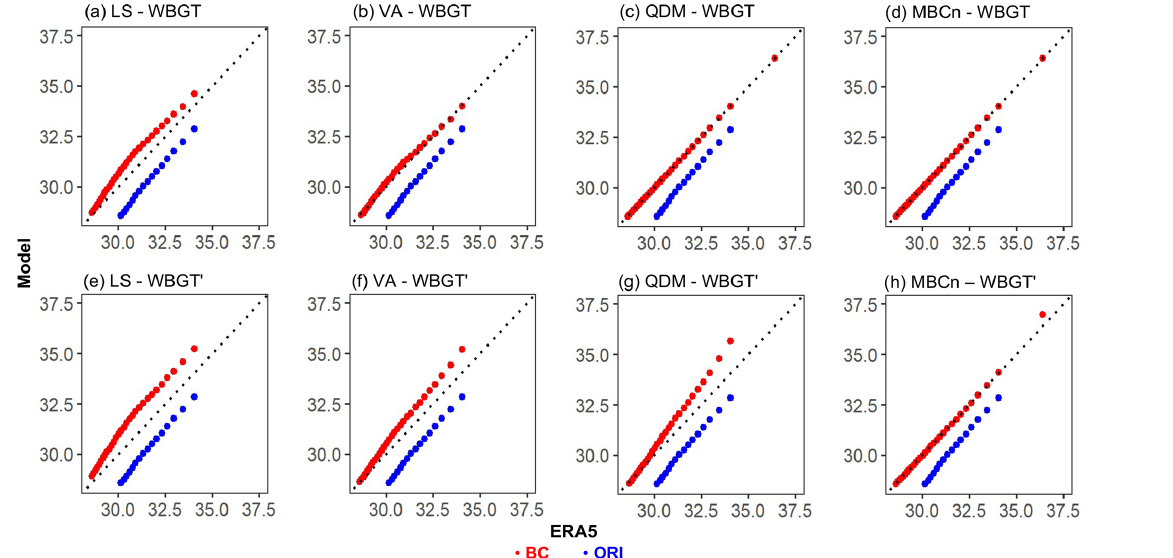
Figure 2. The quantile–quantile plots of ORI (blue) and data after BC (red) adjusted by (a, e) LS, (b, f) VA, (c, g) QDM, and (d, h) MBCn. The x axis is for quantiles from ERA5, and the y axis is for quantiles from model simulations; the unit is ◦ C. Panels (a) – (d) are WBGT from direct correction, and (e) – (h) are WBGT (cid:48) from indirect correction (calculated from directed T and RH). The data are from one point in the GRIMs model (one of the five RCMs) over South Korea land during the calibration period.